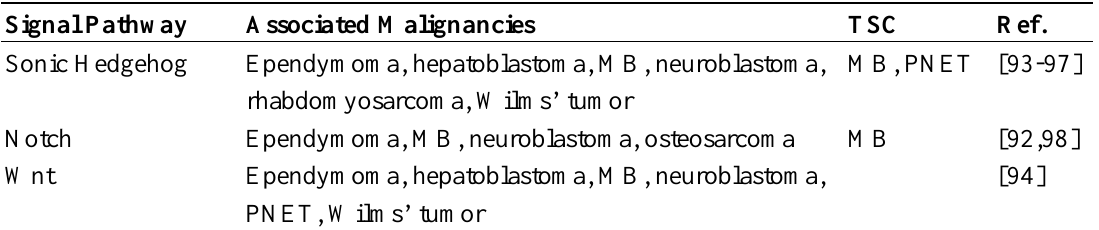
Table 2. Pediatric solid tumors and tumor stem cells (TSC) associated with aberrant